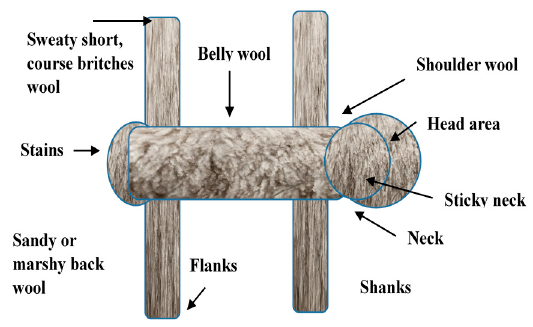
Figure 4. Schematic diagram of wool fleece from various sheep body parts.